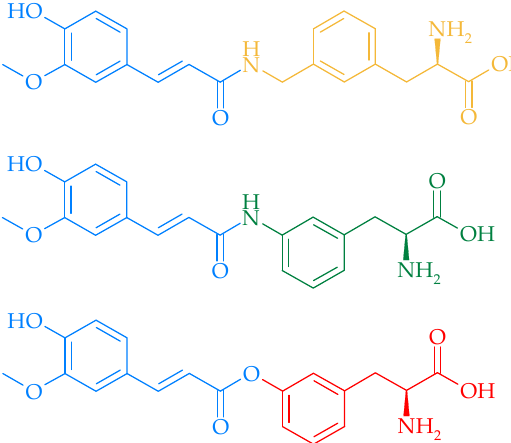
Figure 3. Chemical structures of FA prodrugs based on L-type aminoacids.